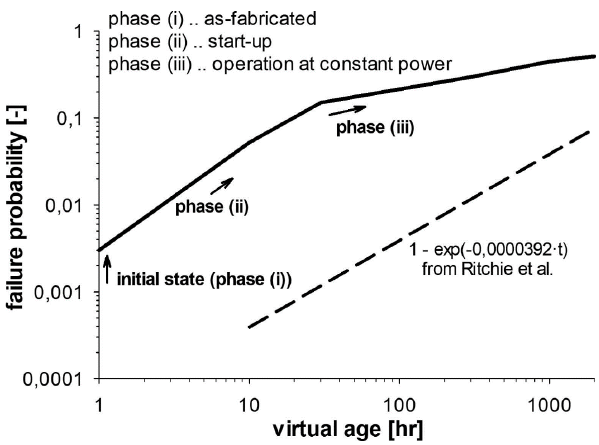
Figure 11. Failure probability function in comparison to that from [44]. Reprinted with permission from Ref. [43]. Copyright 2021, Elsevier.